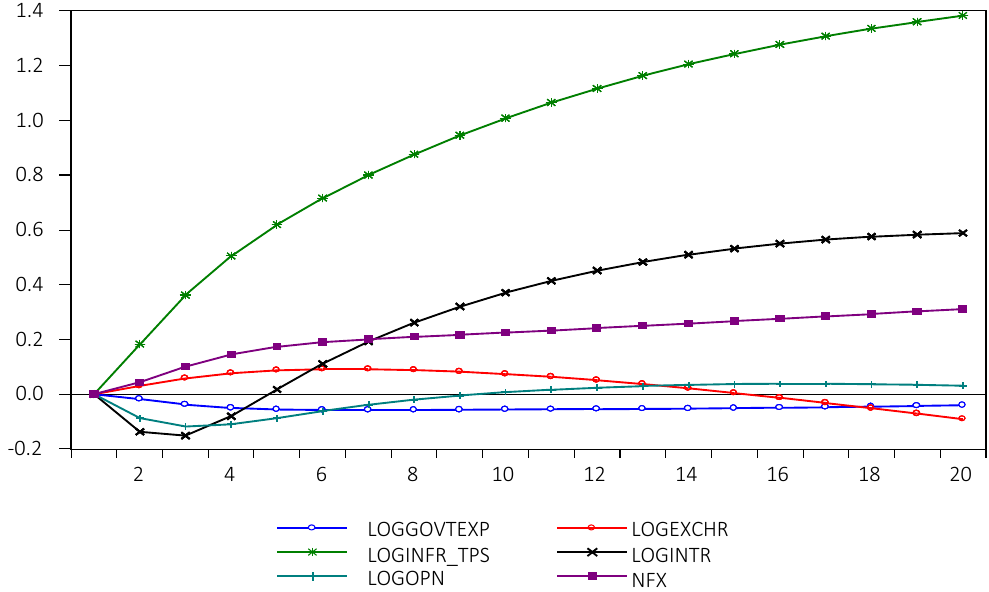
Figure 1. Combined responses of inflation to one standard deviation shocks from internal and external drivers of